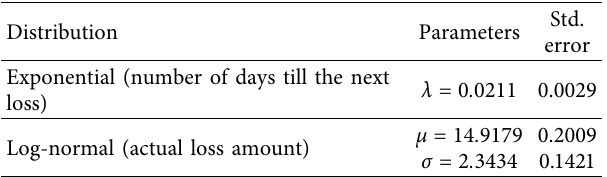
Table 7: Cyber loss distribution